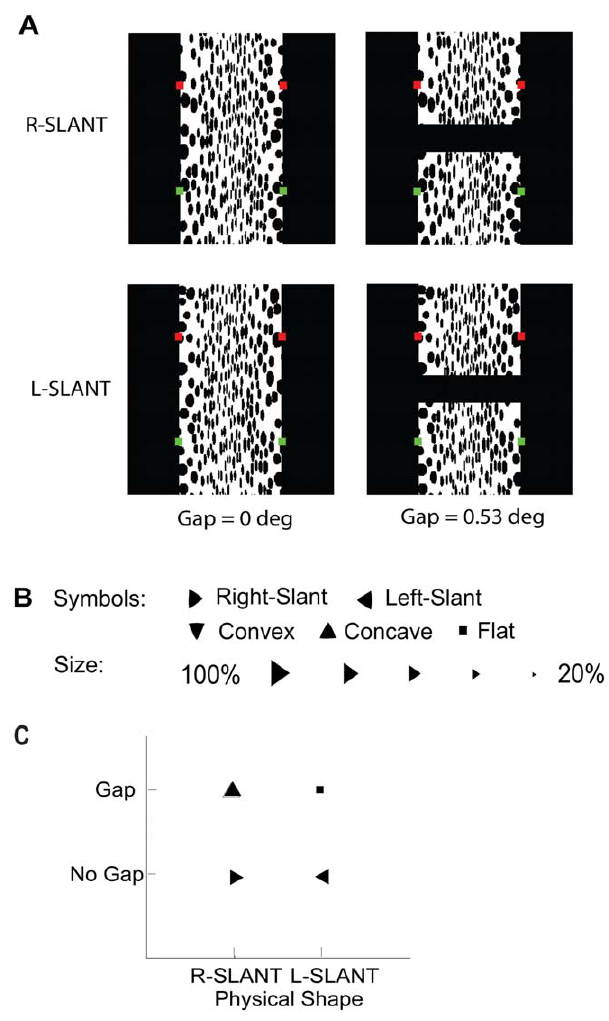
Figure 5. Results of Experiment 3. (A) Experiment 3 stimuli: Left- Slant and Right-Slant surfaces covered by random dots, with or without a gap of 0.53 deg in the center. The red squares indicate the location of touching, and the green squares the location of looking. (B) Symbols: Most frequently reported shape (10 trials 6 3 observers). Size: Proportion of majority responses per condition. (C) Data panel shows shape reported most frequently when viewing L-slant and R-slant sinusoidal corrugations covered by random-dot texture after 40 sec of haptic feedback consistent with simulated 3-D shape. The effect of haptic feedback propagates over the continuous surface although reduced considerably, but is attenuated drastically when a gap interrupts the